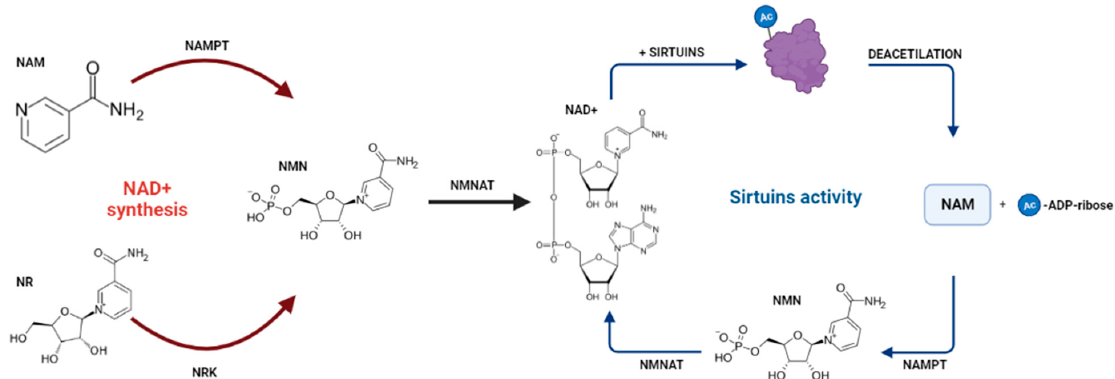
Figure 1. In the process of NAD+ formation, Free Nicotinamide (NAM) is converted to Nicotinamide (NMN) by the action of the enzyme Nicotinamide phosphoribosyltransferase (NAMPT). The same result is obtained when supplemental Nicotinamide Riboside (NR) is converted to NMN by the enzyme Nicotinamide Riboside Kinase (NRK). NMN is converted to NAD+ by the enzyme NMN Adenyltransferase (NMNAT). Upon binding with the SIRTs, NAD+ is hydrolyzed, the acetyl group attached to the protein is removed, deacetylating the protein and, as a result, NAM and 2’ − O − acetyl − ADP − ribose are released. Finally, NAM returns to the NAD+ formation cycle, restarting the cycle.